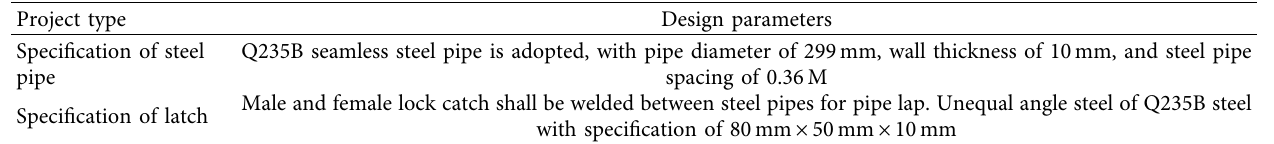
Figure 9: Detailed drawing of tube curtain connection and settlement history of monitoring points. Table 3: Selection of pipe curtain